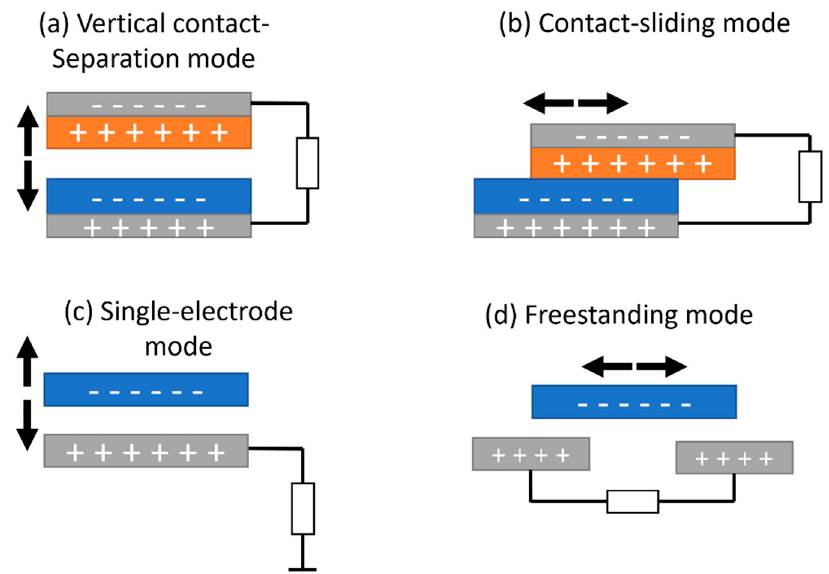
Figure 8. Fundamental operational modes of TENG: ( a ) vertical contact-separation mode, ( b ) contact-sliding mode, ( c ) single-electrode mode, ( d ) freestanding triboelectric-layer mode [9].